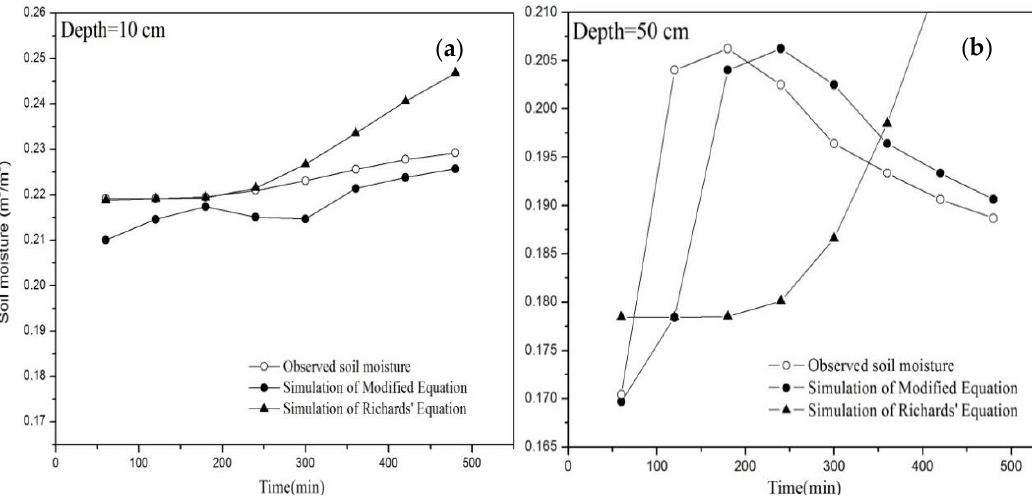
Figure 4. Comparison of simulated and observed soil moisture at various measurement points and soil depths.